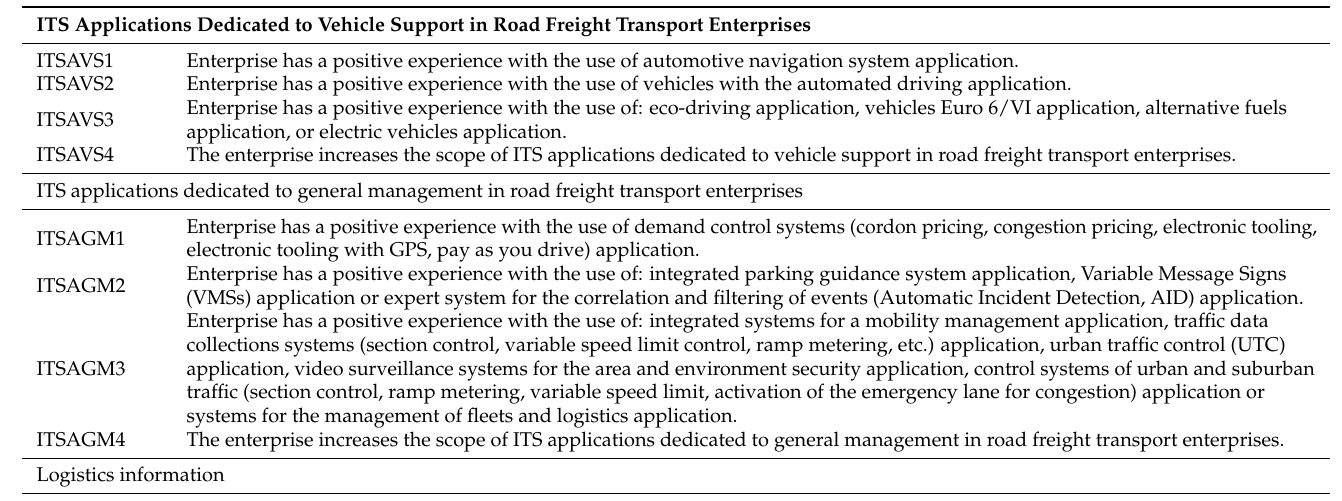
Table A1. Measurement